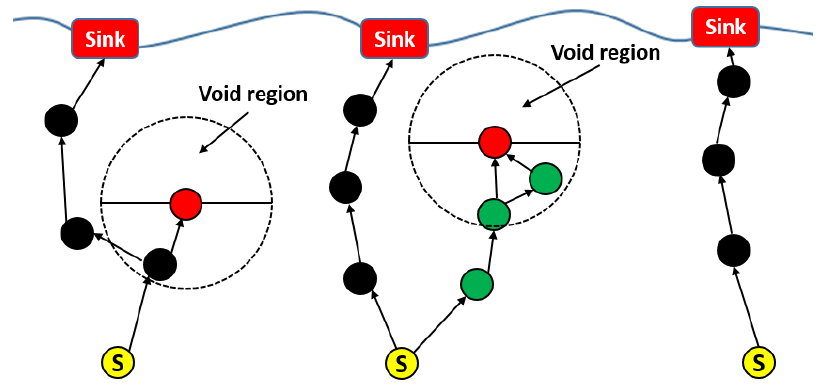
Figure 11. Void regions and trapped nodes problem.